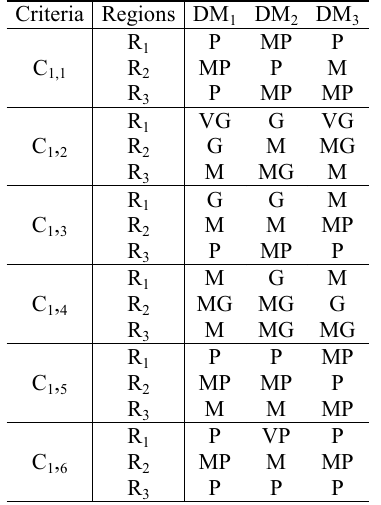
Table 4. Evaluation of alternatives with respect to